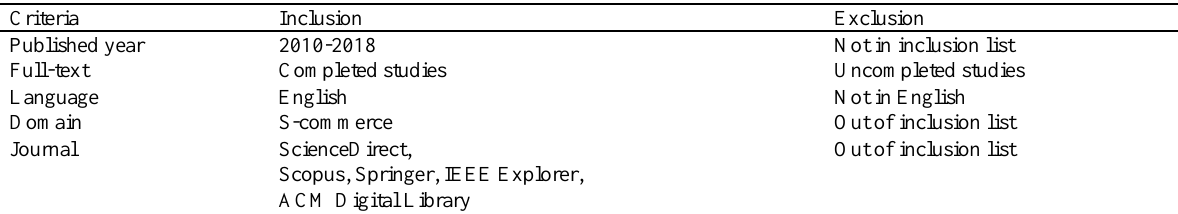
Table 2: Inclusion and exclusion criteria